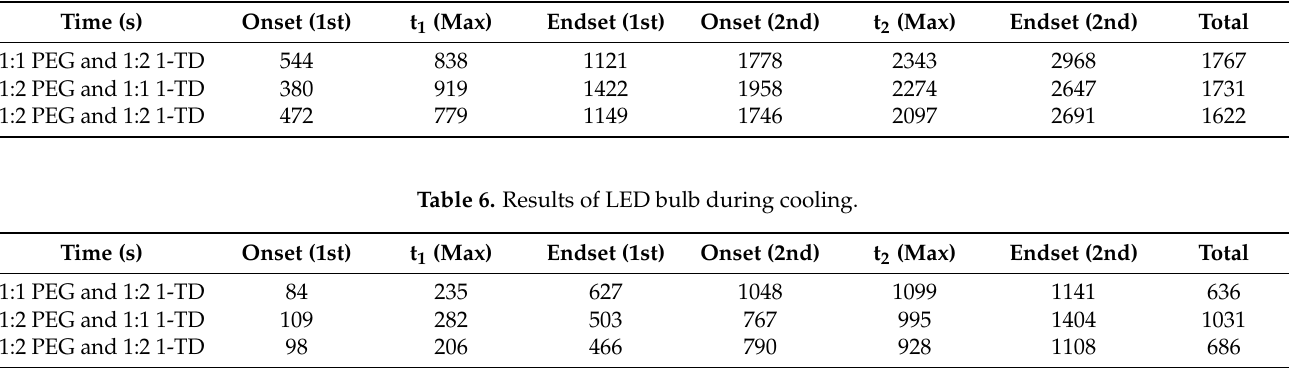
Figure 12. LED bulb images during the ( a ) heating process and ( b ) cooling process. Light intensities during heating for ( c ) 1:1 PEG and 1:2 1-TD composites, ( d ) 1:2 PEG and 1:1 1-TD composites and ( e ) 1:2 PEG and 1:2 1-TD composites. Light intensities during cooling for ( f ) 1:1 PEG and 1:2 1-TD composites, ( g ) 1:2 PEG and 1:1 1-TD composites and ( h ) 1:2 PEG and 1:2 1-TD composites. Table 5. Results of LED bulb during heating.